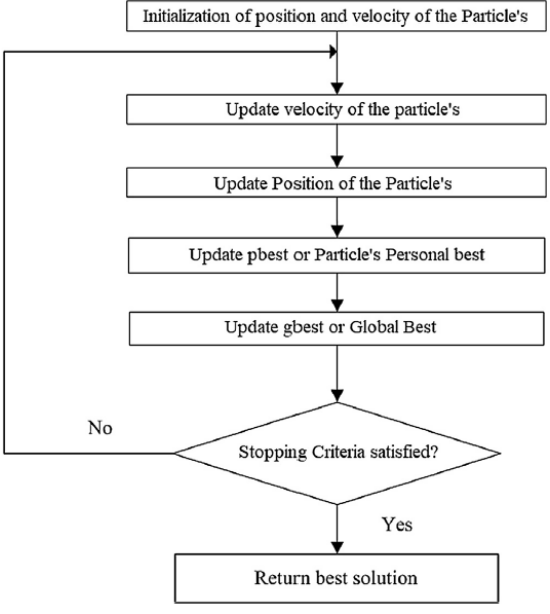
Figure 4. Particle Swarm Optimization [29].